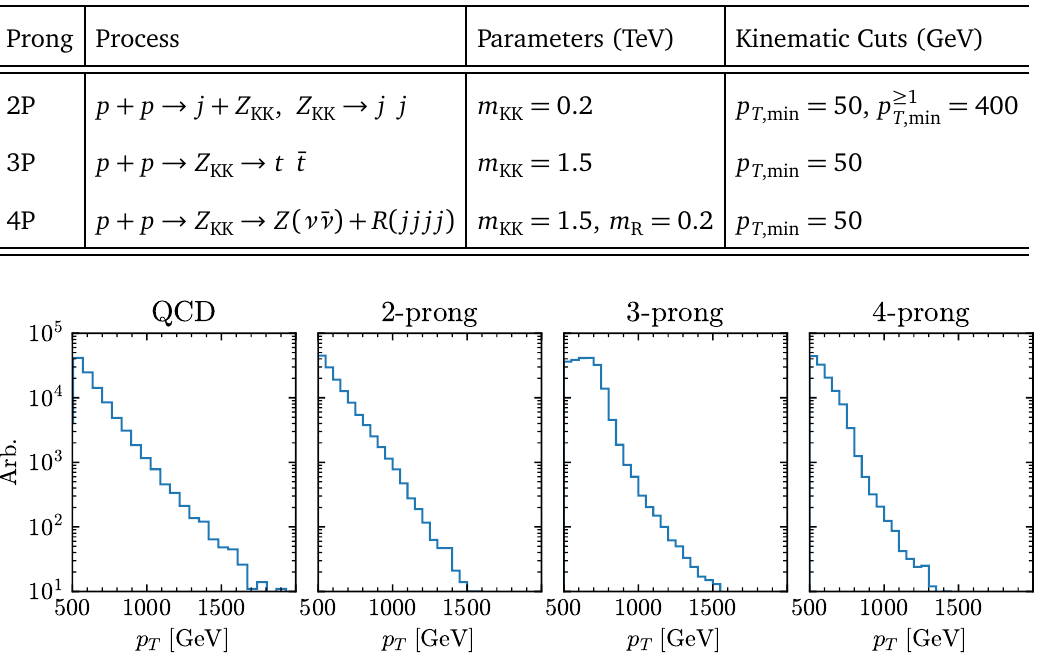
Figure 1: Distributions of the transverse momentum of the hardest